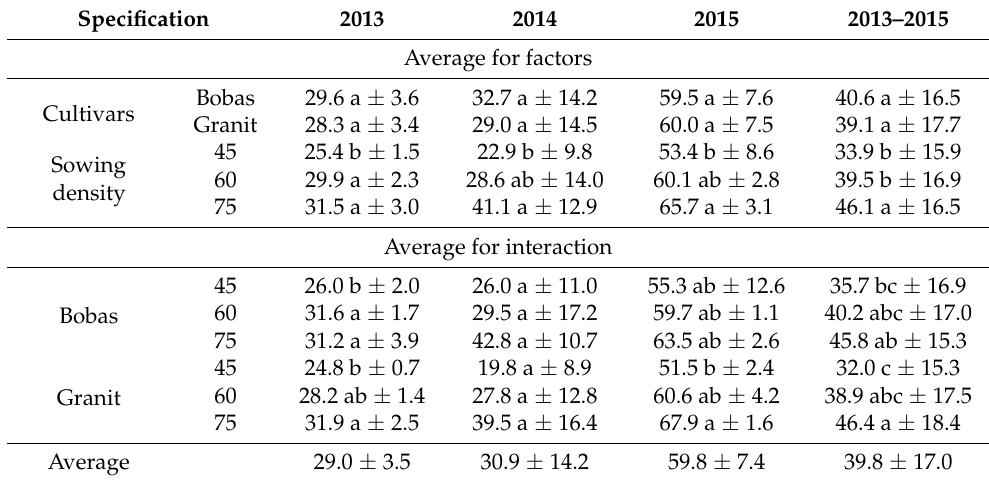
Table 9. Potassium accumulation in the faba bean straw (kg ha − 1 ) as influenced by the examined factors during the study years 2013–2015.